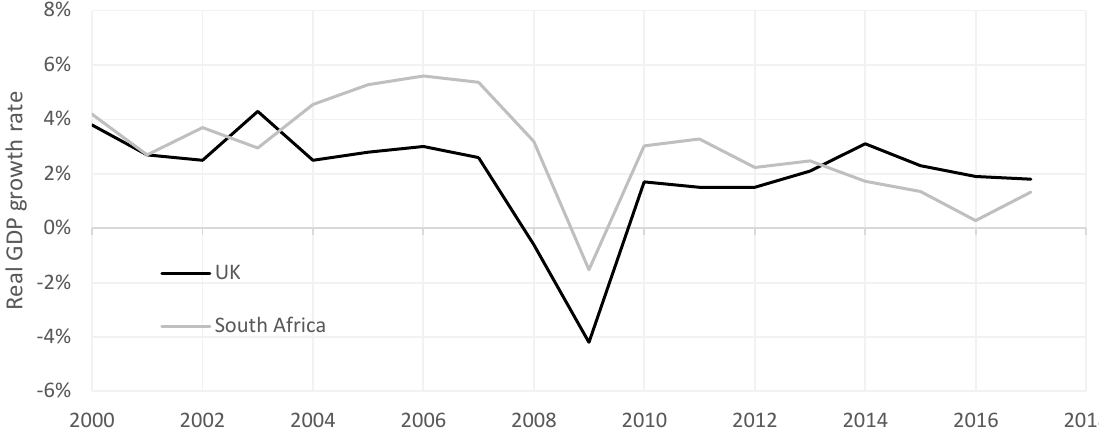
Source: Thomson Reuters.